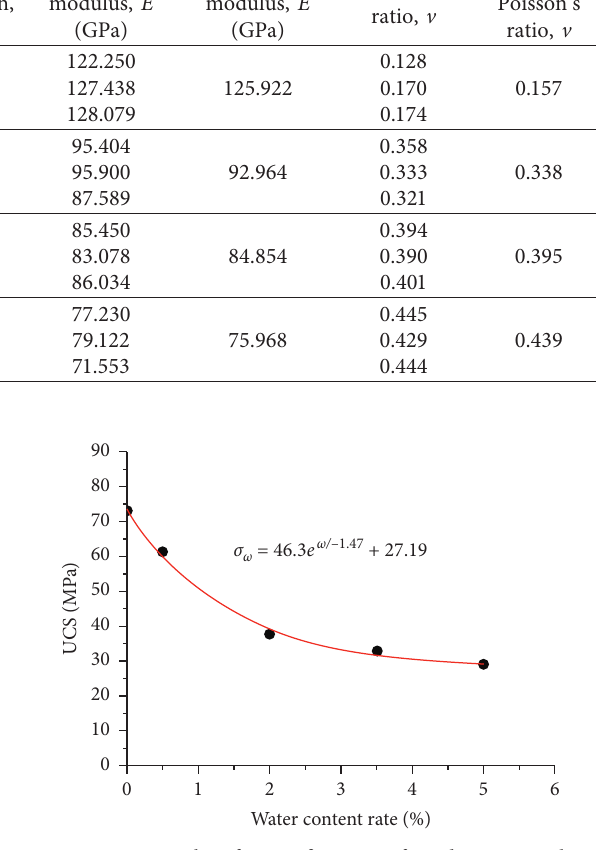
Figure 6: Strength softening fit curve of sandstone